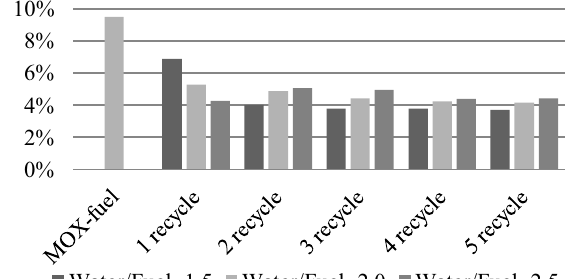
Fig. 5. RgPu consumption on the each recycle during the multiple recycling of the REMIX(MOX)-fuel for each FA concepts.